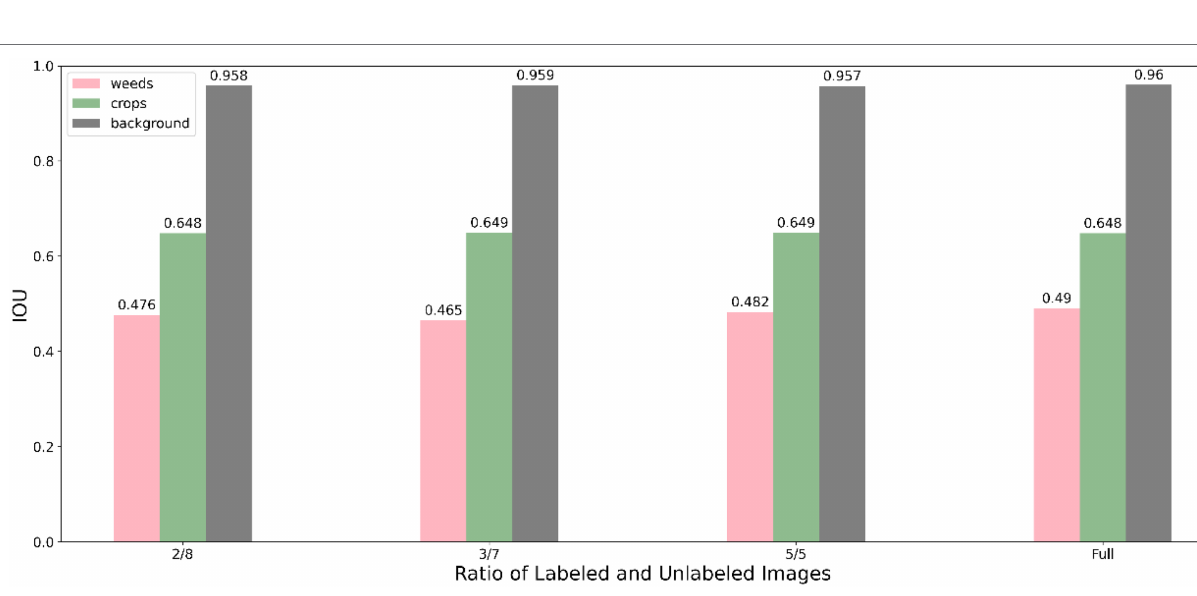
FIGURE 6 | Performance of the proposed method using Resnet 101 under different labelled data proportions.